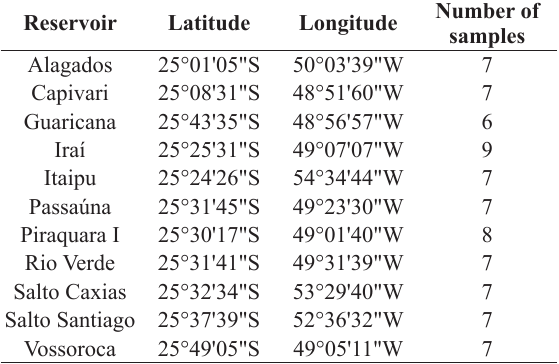
Geographic location of reservoirs and number of samples taken in each reservoir from 2005 to